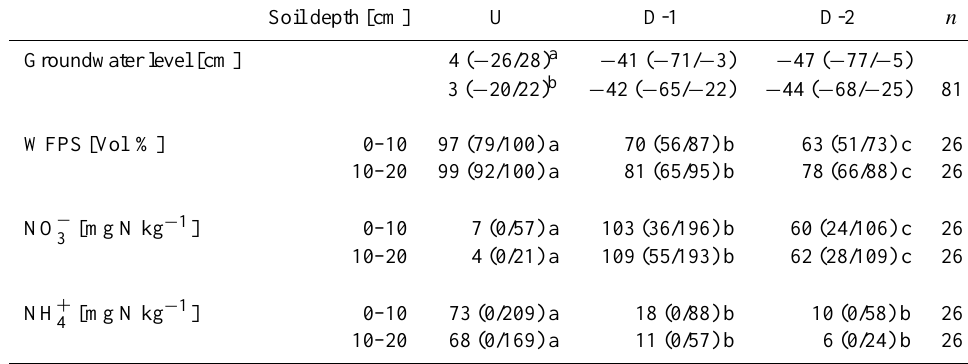
Table 1. Groundwater level, water-filled pore space (WFPS), extractable nitrate (NO − the year 2011.